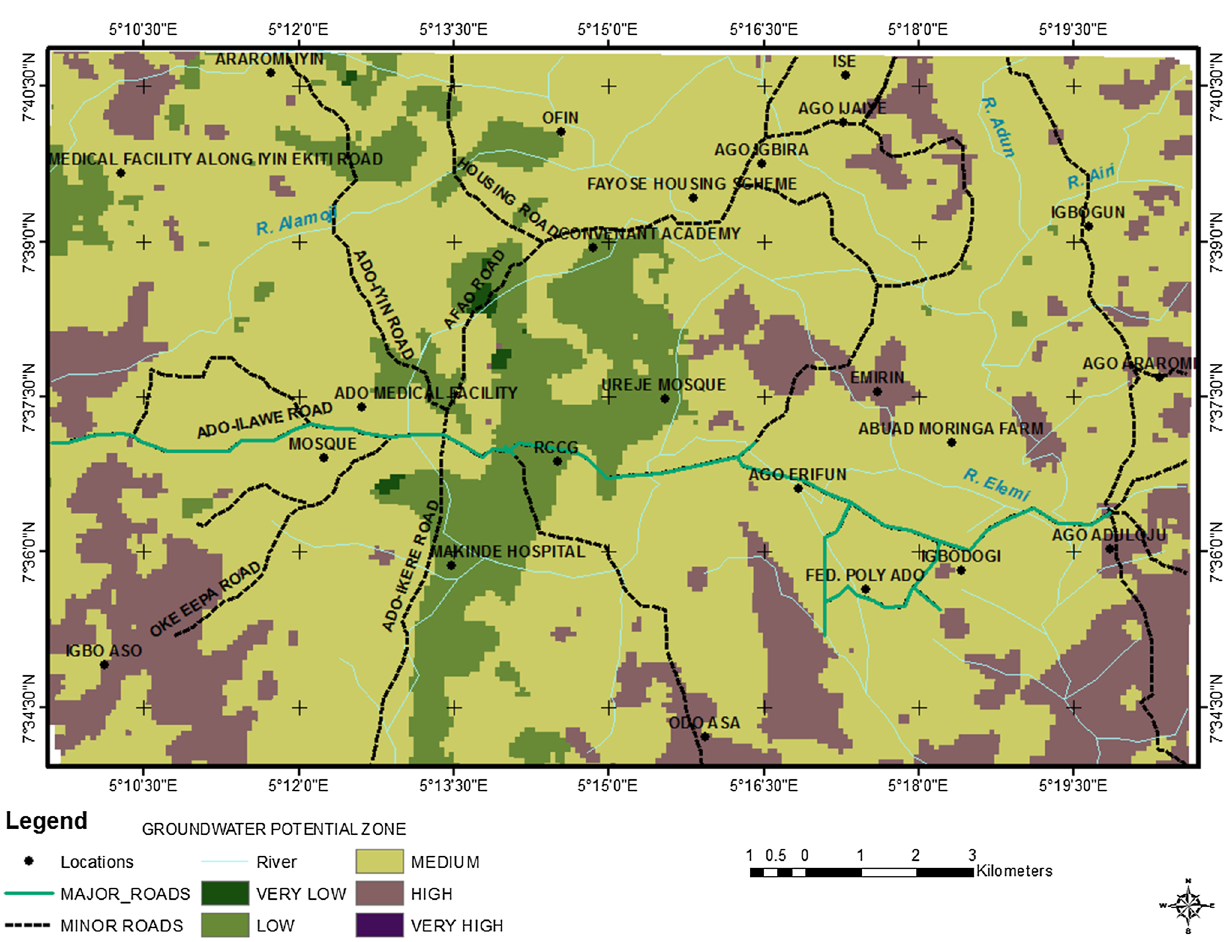
Fig. 10 Groundwater potential map of the Ado-Ekiti area, SW,